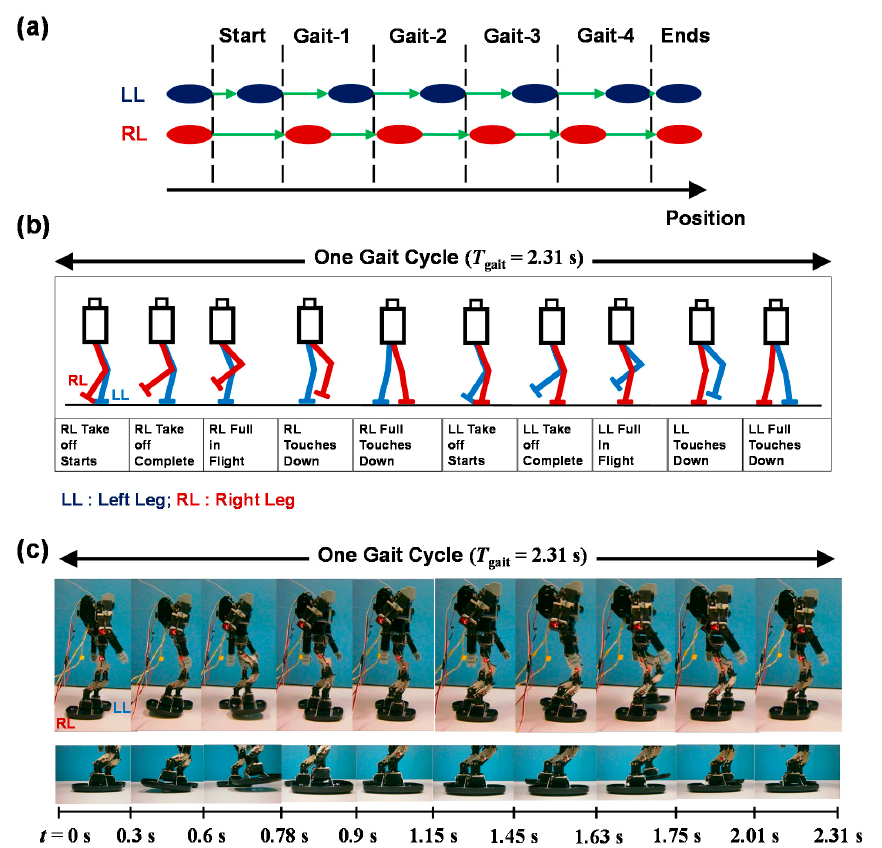
Figure 3. ( a ) Walking-motion scheme for the robot experiments, illustrating the gait-cycle repetition of the robot, with one half of a gait cycle at the beginning, then four complete gait cycles and finally one half of a gait cycle at the end. ( b ) One gait cycle is zoomed to show the gait pattern of the robot KONDO KHR-3HV. T gait : Period of a gait cycle; T walk : Total time for which the robot has walked. ( c ) Photos showing the gait pattern implemented in one gait cycle of the robot with the zoomed foot-placements patterns at the bottom.